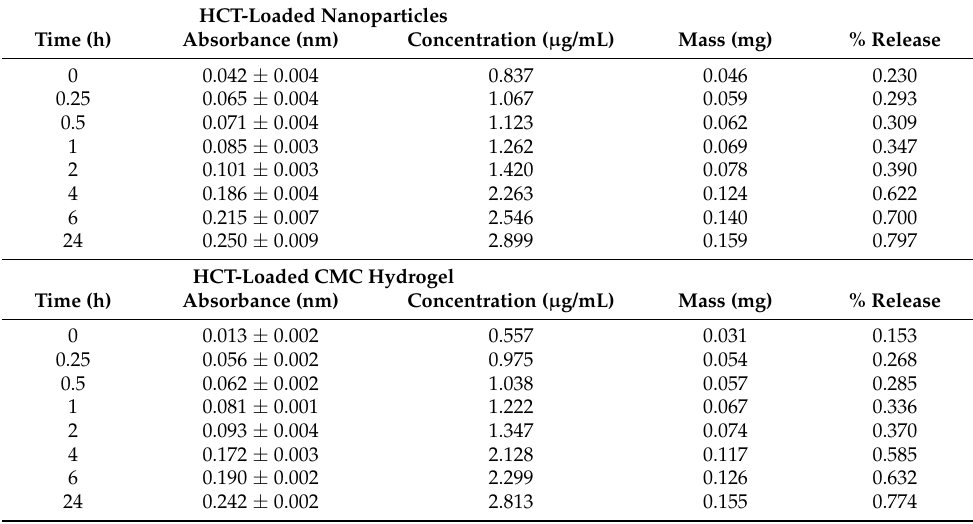
Table 1. HCT drug-release profiles at pH 5.2.